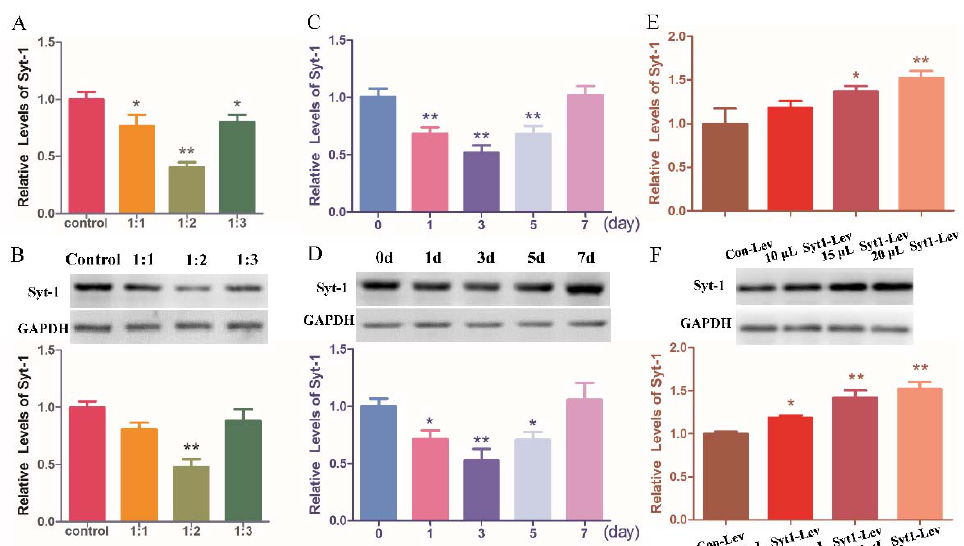
Figure 10. Exploration of the optimal conditions for Syt-1 interference and overexpression (Mean ± SD, n = 3). ( A , B ) Five microliters of Syt-1 siRNA in mixture with 10 µ L lipofectamine (1:2) caused less Syt-1 mRNA and protein expression compared with the other ratios; * p < 0.05, ** p < 0.01, vs. control group. ( C , D ) After a bolus administration of the optimal Syt-1 siRNA vs. lipofectamine ratio (1:2), decreased Syt-1 expression lasted for 5 days at least; * p < 0.05, ** p < 0.01, vs. 0 d group. ( E , F ) Intrathecal injection of 15 µ L Syt-1 lentiviral activation particles caused increased Syt-1 mRNA and protein compared with control lentiviral particles; * p < 0.05, ** p < 0.01, vs. Con-Lev group. A, C, and E show Syt-1 mRNA; B, D, and F show Syt-1 protein. In the control (A and B), phosphate bu ff er saline (PBS) instead of the Syt-1 siRNA mixture was intrathecally administered. The significance of di ff erences was calculated with a one-way ANOVA followed by a Bonferroni test.